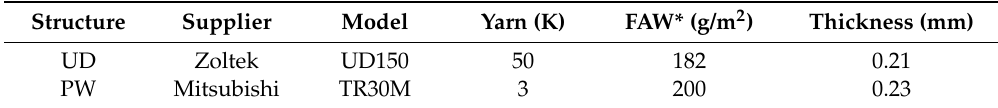
Table 1. Basic properties of the used carbon fabrics.